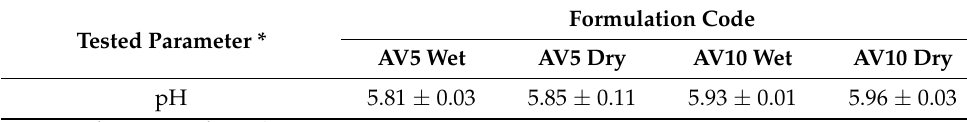
Table 1. pH values of wet and dry samples. Tested Parameter